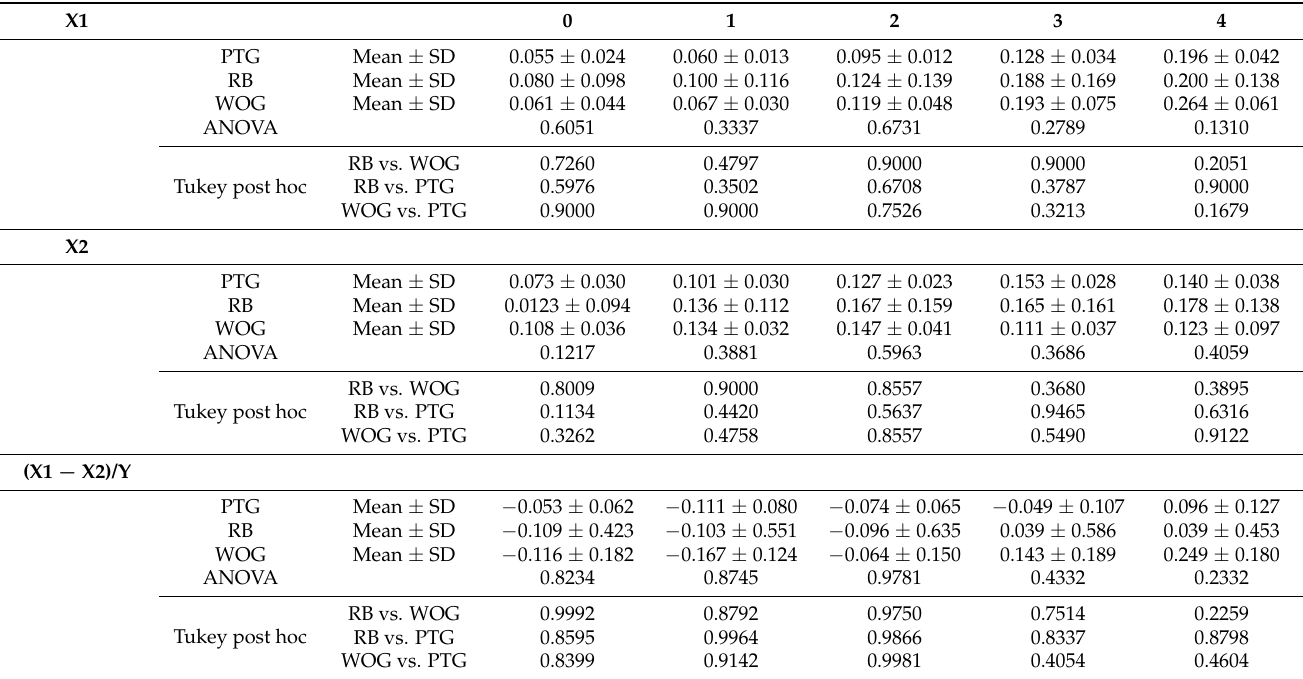
Table 1. X1, X2, and X1 − X2/Y mean value, standard deviation SD and ANOVA with Tukey’s post hoc test for the apical